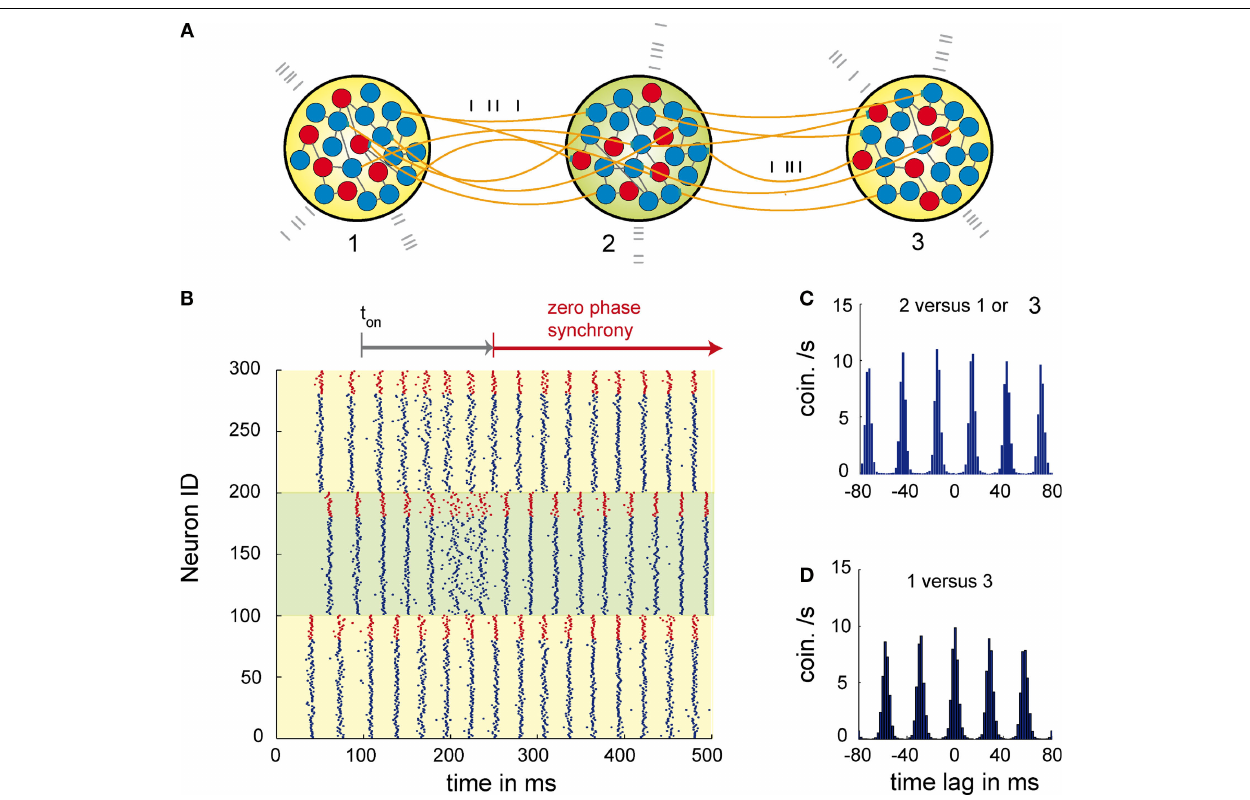
FIGURE 1 | Dynamics of three networks of excitatory and inhibitory populations was activated. After 90 ms of activated coupling P1 and P3 start neurons interacting through dynamical relaying. (A) Topology of the being zero-phase synchronized. The whole synchronization period lasts relaying motif. Here, three networks 1, 2, 3 each composed of 20 inhibitory about 130 ms. Note that the activity of the relaying population P2, gets less (red) and 80 excitatory (blue) neurons. To control the activity level of each synchronized due to individual phase adaptations of P2 neurons during the population external Poisson input is used (grey spikes). The conductions synchronization period between 160 and 230 ms. This indicates that the delays are 12 ms and therefore signifi cant compared to the period of the relaying population P2 is not acting as a master that entrains P1 and P3, but oscillation. (B) Raster plot of the activity of each neuron of population 1 that synchronization is established between P1 and P3 via relaying of activity (neurons 1–100), population 2 (neurons 101–200) and population 3 (neurons through P2. (C) Average cross-correlation between population P1 or P3 and 201–300). Blue spikes are from the excitatory and red spike from the the relaying population P2. (D) Average cross correlation between the outer inhibitory neurons. At coupling t at 100 ms the coupling between the populations P1 and on